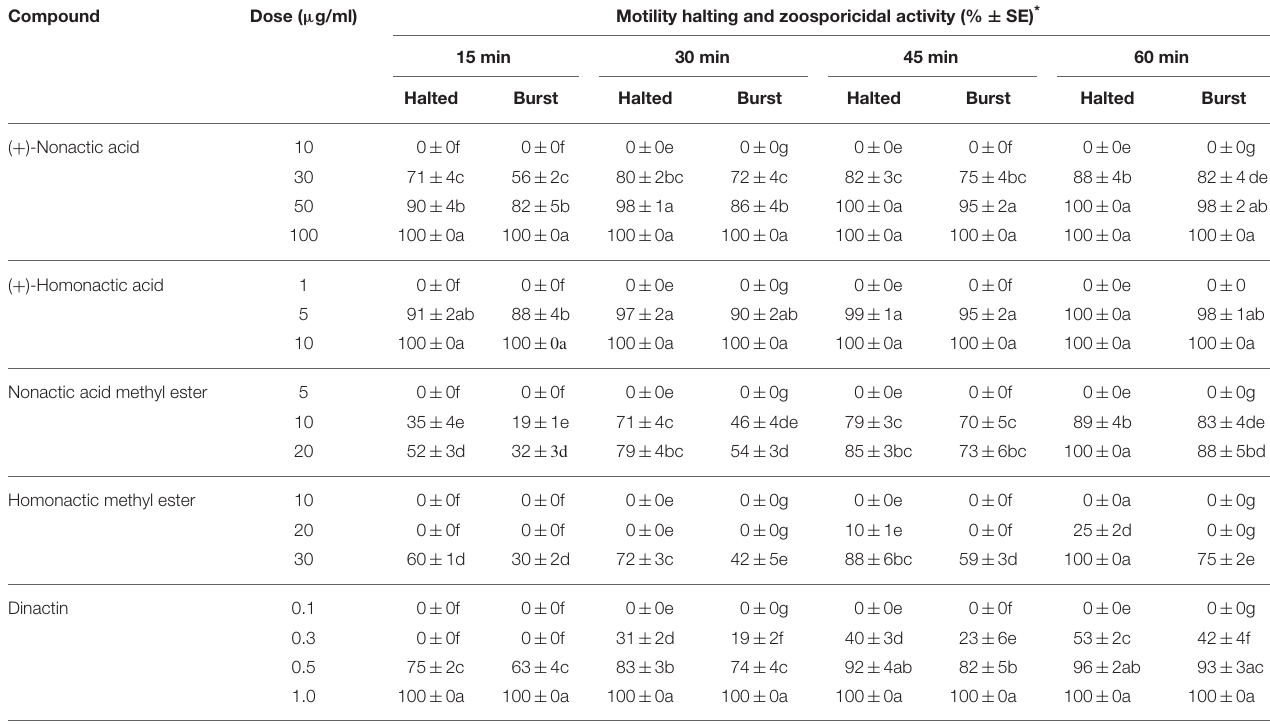
TABLE 2 | Motility halting and zoosporicidal activity of nactic acids and their esters and dinactin isolated from marine Streptomyces sp. Act 8970 against the grapevine downy mildew pathogen Plasmopara viticola . Compound Dose ( µ g/ml) Motility halting and zoosporicidal activity (% ± SE) *